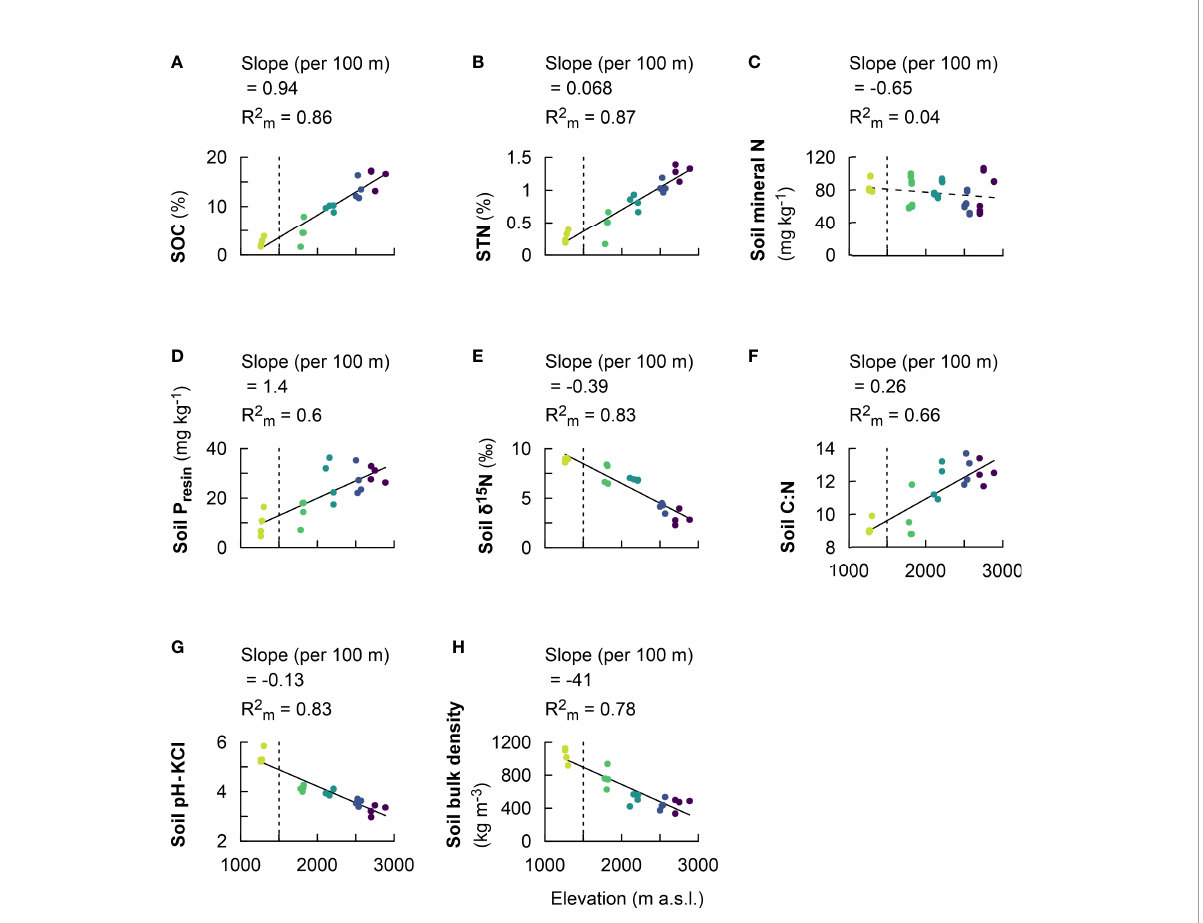
FIGURE 2 Fixed effect estimates of elevation (per 100-m elevation increase) for topsoil physicochemical properties: soil organic carbon (SOC) (A) , soil total nitrogen (STN) (B) , soil mineral nitrogen (C) , soil resin phosphorus (P resin ) (D) , soil d 15 N (E) , soil C:N (F) , soil pH-KCl (G) , and soil bulk density (H) . The slope of the linear mixed effect model estimates per 100 m of elevation increase is indicated (black solid line for a signi fi cant effect and black dashed line for no signi fi cant effect), as well as the marginal R 2 (R 2 m ) , representing the fraction of the response variable explained by elevation. Plots from montane forest clusters (from 1,750 to 3,000 m a.s.l.) were compared with a nearby premontane forest (separated by vertical dashed line) at an elevation of 1,250 – 1,300 m